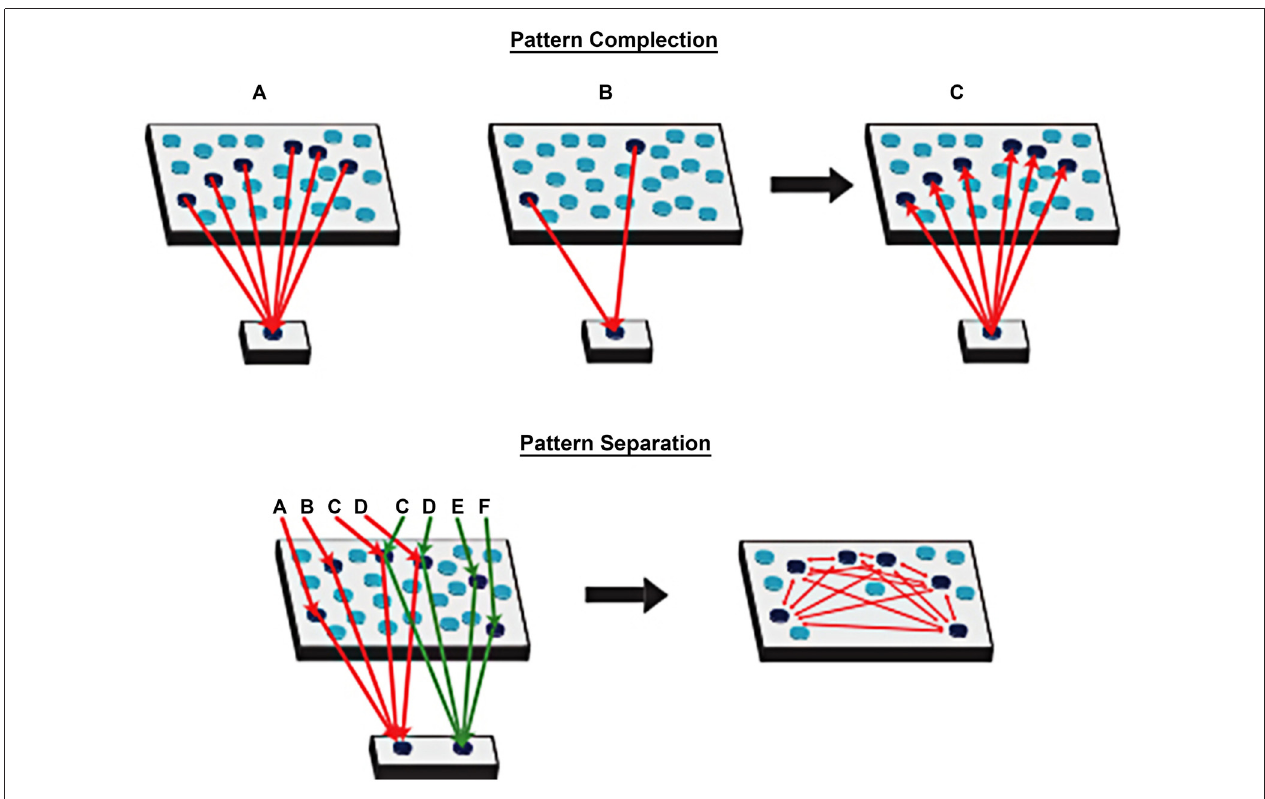
the neocortex to activate the entire pattern. Pattern separation: the hippocampal formation supports pattern separation with the creation of different output firing pattern for similar inputs (Adapted from Rudy,